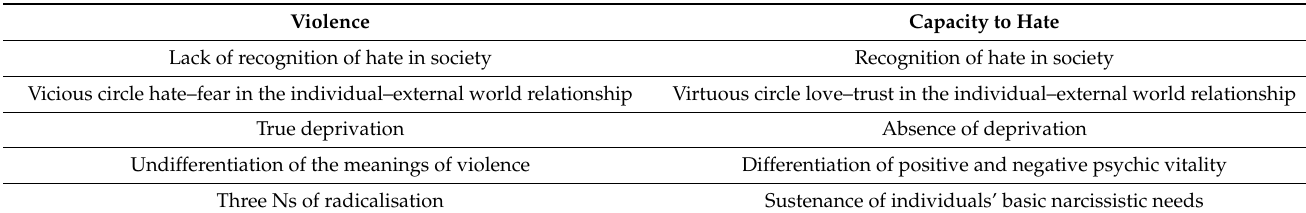
Table 1. Different characteristics underlying violence and the capacity to hate.